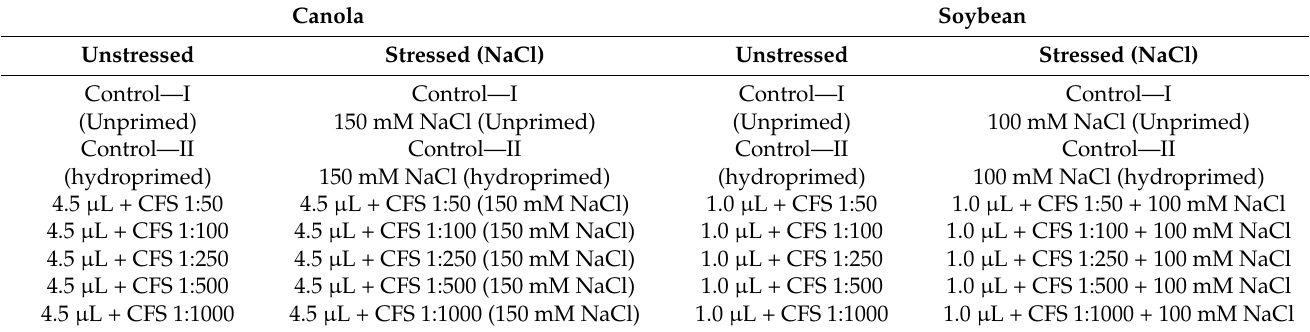
Table 3. Flavonoids and cell-free-supernatant-combined treatments for canola and soybean seed germination. Experimental